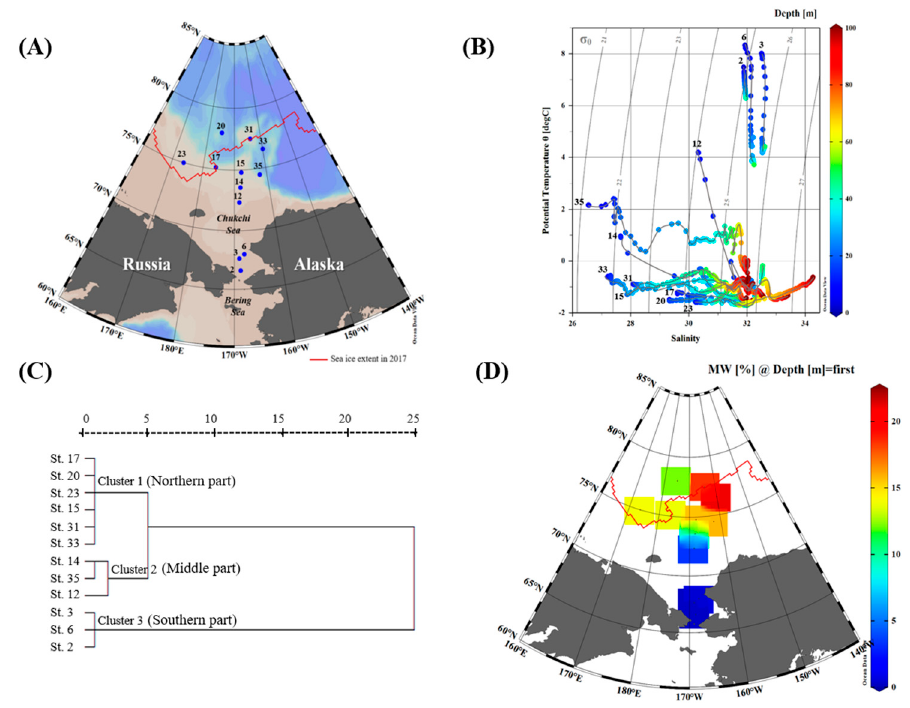
Figure 1. ( A ) Location of sampling area in the Chukchi Sea, August 2017. Sea ice extent for the month of August in 2017 (red line) was obtained from the National Snow and Ice Data Center (NSIDC, Fetterer et al. [38]). ( B ) Temperature-salinity diagram from surface to 100 m depth (labeled with station numbers in bold black at the surface); ( C ) cluster analysis of the surface potential temperature and salinity data allowed identification of 3 types of the regions in the Chukchi Sea, ( D ) MW (%) distributions at surface water in the Chukchi Sea during a summer cruise in August 2017. (Ocean Data View (ODV) version 5.1.0) (AWI, Bremerhaven, Germany, Schlitzer, R.).